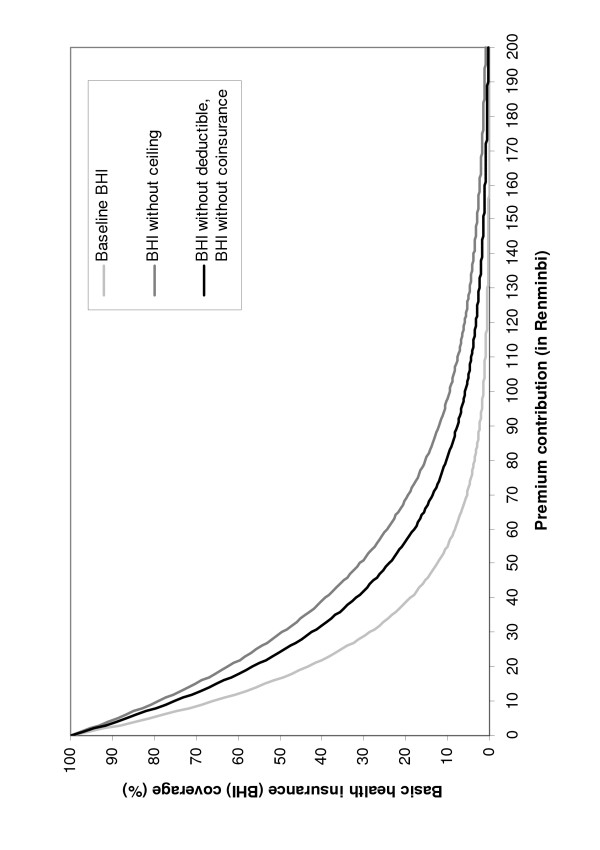
Demand for basic health insurance.